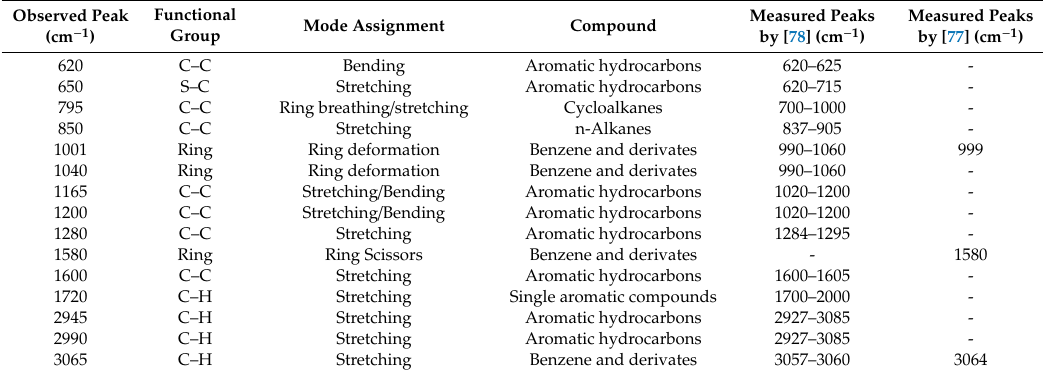
Table 1. Raman vibrations (cm − 1 ) of FIA1 and FIA2 fluid inclusions. The identified peaks are compared with the main range of vibrations for aromatic hydrocarbons, alkanes, and the benzene group [77,78]. Observed Peak (cm − 1